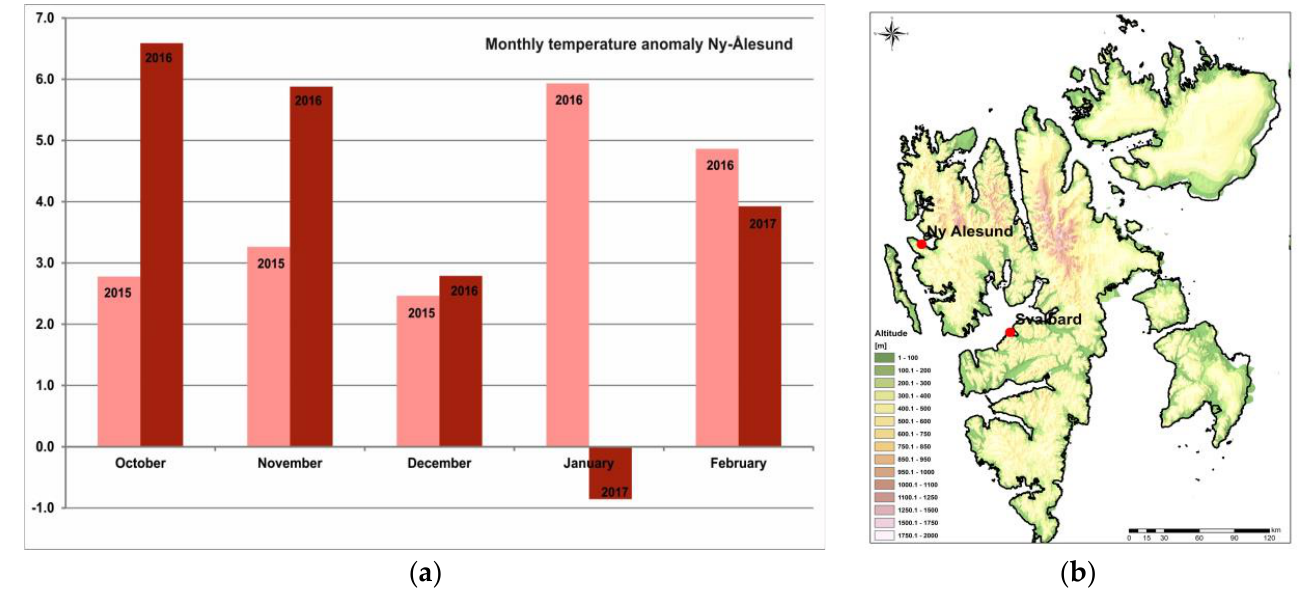
Figure 8. ( a ) The 2 m air temperature anomaly at Ny-Ålesund station for winters 2015/16 (pink) and 2016/17 (red) and ( b ) the geographical location of Ny-Ålesund station. The anomalies are computed to the reference period 1994 – 2015. Data source: AWIPEV Base.